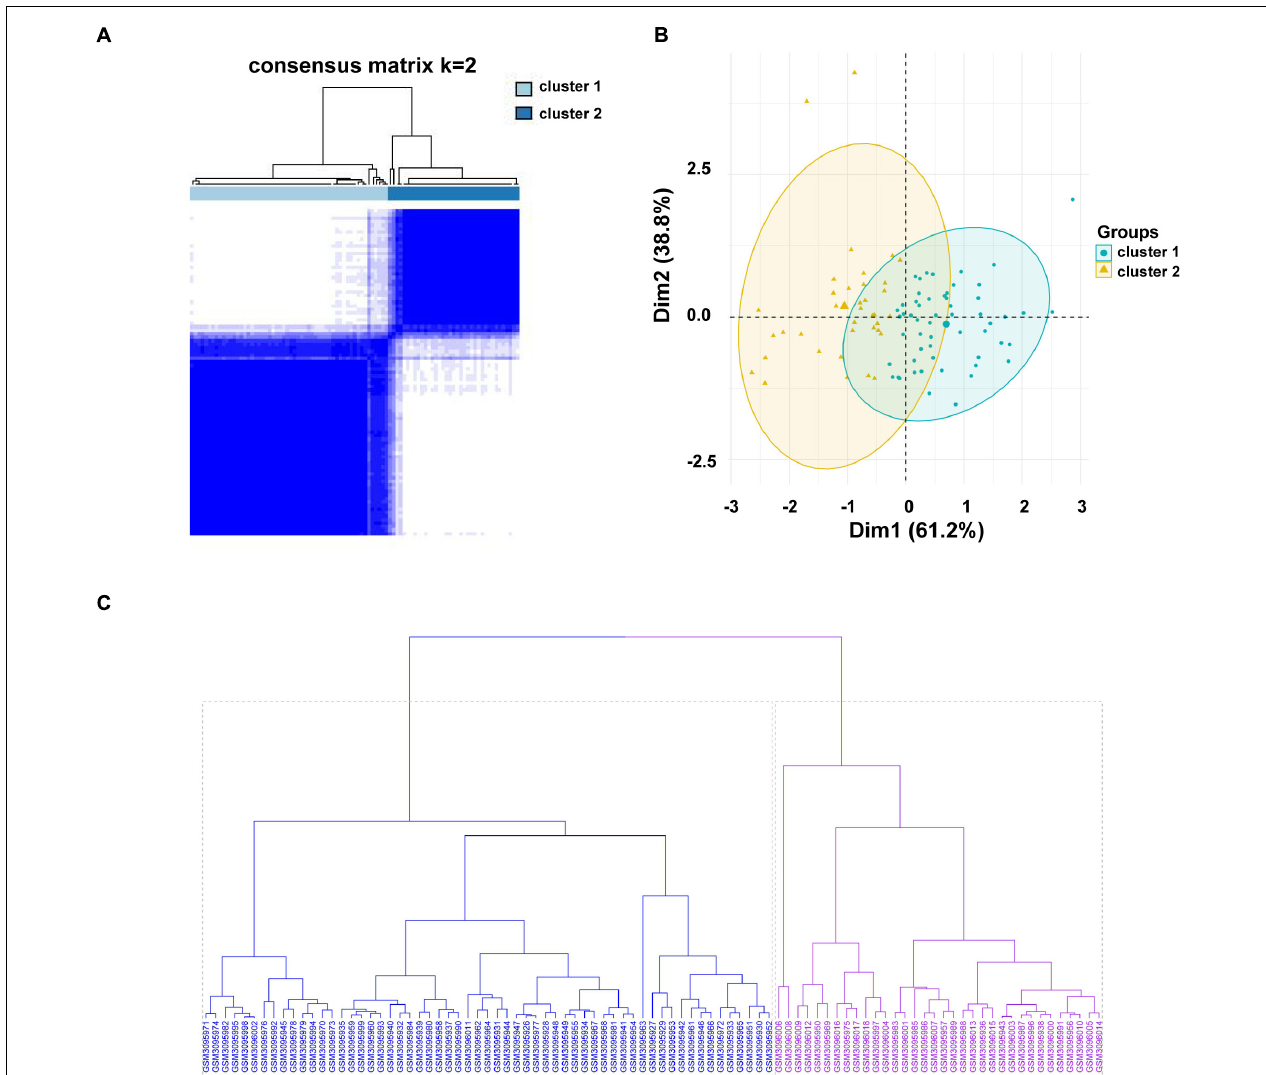
FIGURE 6 | Consensus clustering analysis of the hub immune-related lncRNAs in the CAD samples. (A) The heatmap of the consensus matrix with a cluster count of 2. (B) Two-dimensional PCA cluster plot of the CAD samples; green points denote the samples of cluster 1 and yellow triangles denote to the samples of cluster 2. (C) Unsupervised hierarchical clustering. Clustering was performed for 93 CAD samples based on the expression values of LINC01480 and AL359237.1. The cluster 1 containing 59 samples is colored in blue, and cluster 2 including 34 samples is colored in purple. lncRNA, long non-coding RNA; CAD, coronary artery disease; PCA, principal component analysis; Hclust, hierarchical